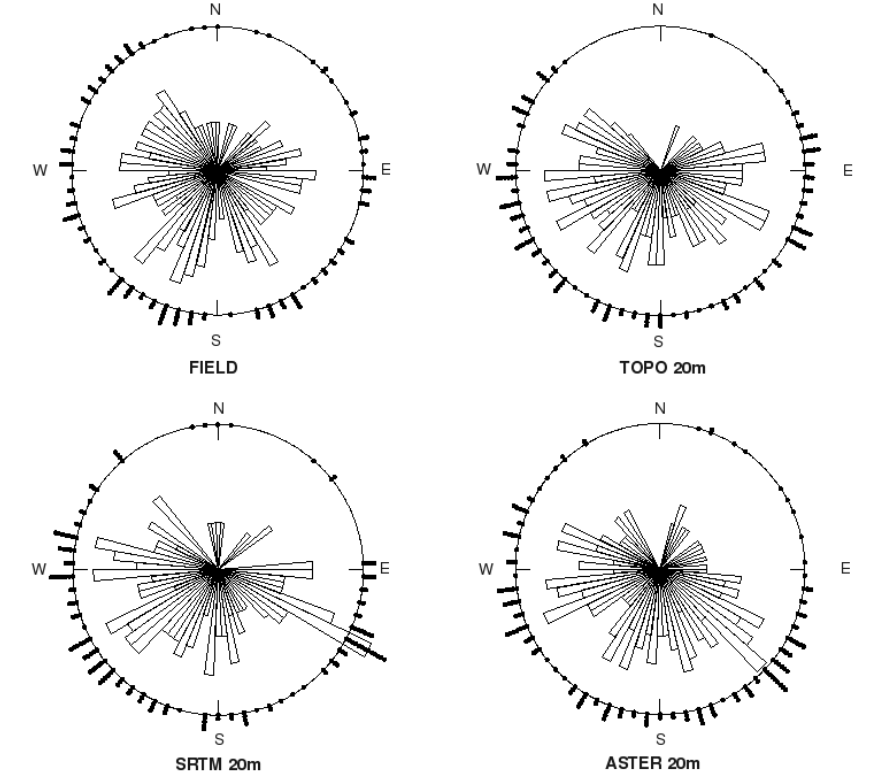
Figure 6. Rose diagrams showing the distribution of aspects in the field and as derived from 20-m resolution DEMs.